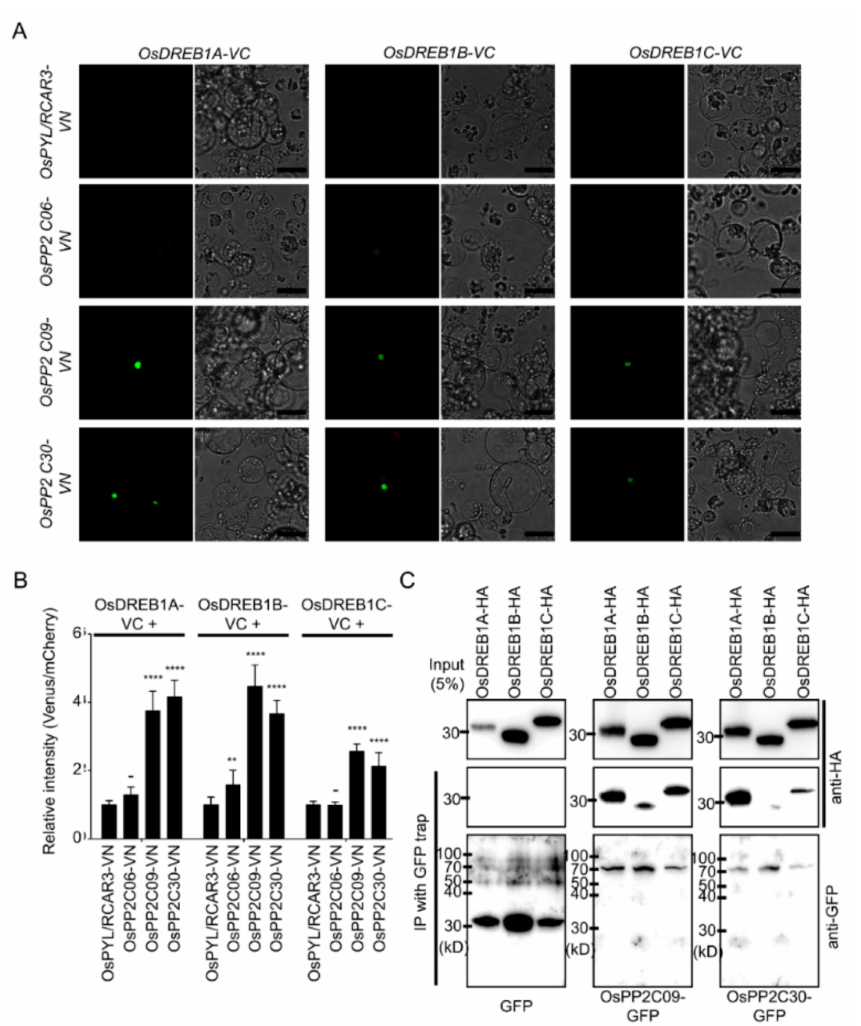
Figure 7. OsPP2CAs interact with OsDREBs. ( A ), Venus C -terminus (VC)-tagged OsDREB1A, OsDREB1B and OsDREB1C were examined with Venus N -terminus (VN)-tagged OsPYL/RCAR3, OsPP2C06, OsPP2C09, and OsPP2C30 by BiFC analysis. Scale bars: 10 µ m. ( B ), BiFC signal intensities normalized to internal control (ER-mCherry). Values are means ± SD ( n > 20 cells) and normalized to BiFC signal for OsPYL/RCAR3-VN and each OsDREBs-VC. One-way ANOVAs were performed with comparing to signals interacted with OsPYL/RCAR3-VN (****: p < 0.0001, **: p < 0.01, -: not significant). ( C ), Co-immunoprecipitation analysis. Indicated constructs were introduced into rice protoplasts and GFP-tagged proteins were pull-downed with GFP-trap beads. An immunoblot analysis was performed with anti-GFP rabbit antibodies or anti-HA rat